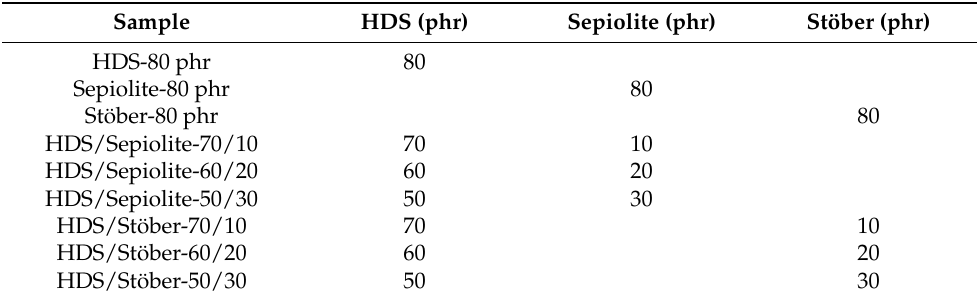
Table 2. Sample classification-filler amount in SBR rubber